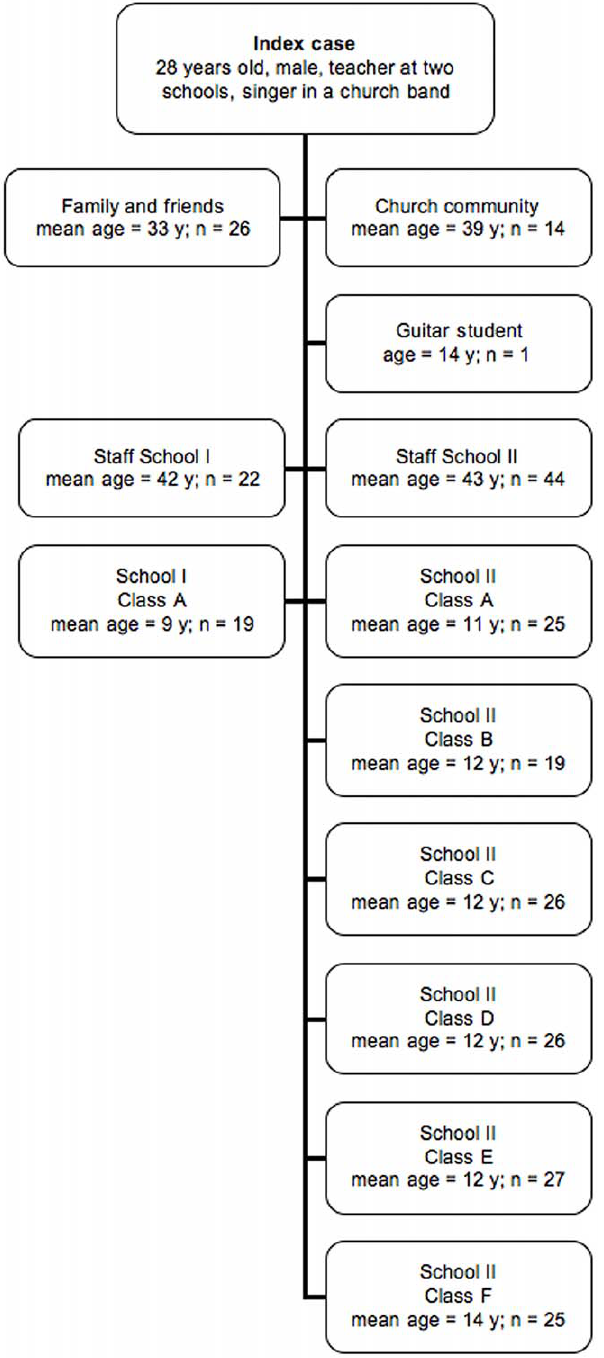
Figure 1. Pattern of exposure among 274 contacts of a teacher with sputum acid fast bacilli smear-positive pulmonary tuberculosis.